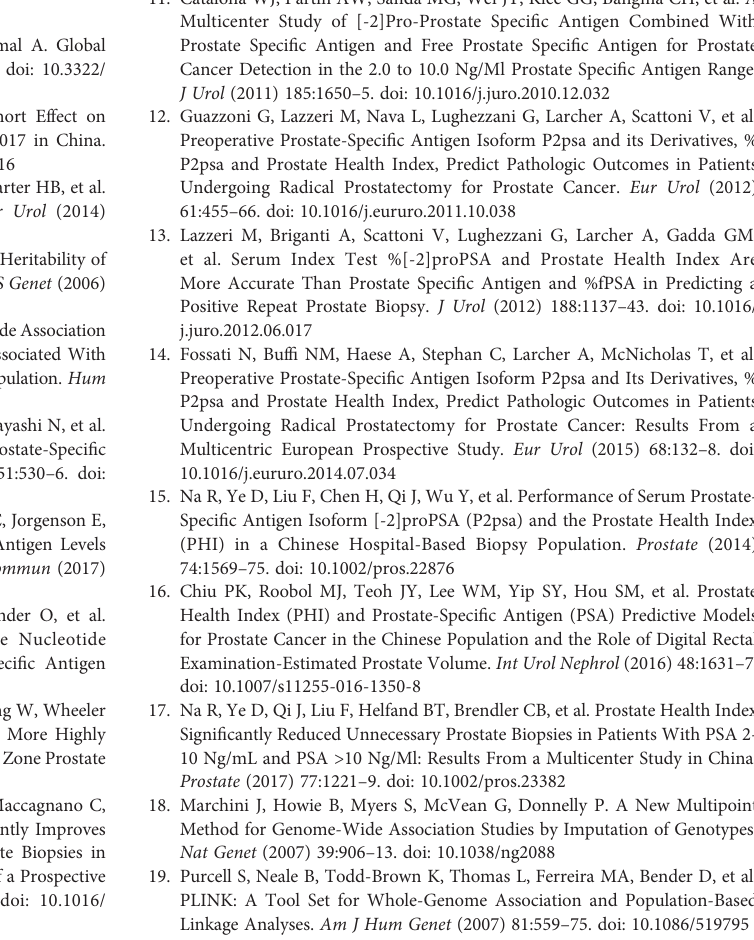
Supplementary Figure 1 | The principal component analysis was conducted in 886 samples in the fi rst stage and 1,978 from 1000 Genomes data by the fi rst two principal components. Supplementary Figure 2 | The quantile-quantile (Q-Q) plot of the expected and observed P values using imputed SNPs data in stage 1. Supplementary Figure 3 | Plot for PCa detection rate by the genotypes of